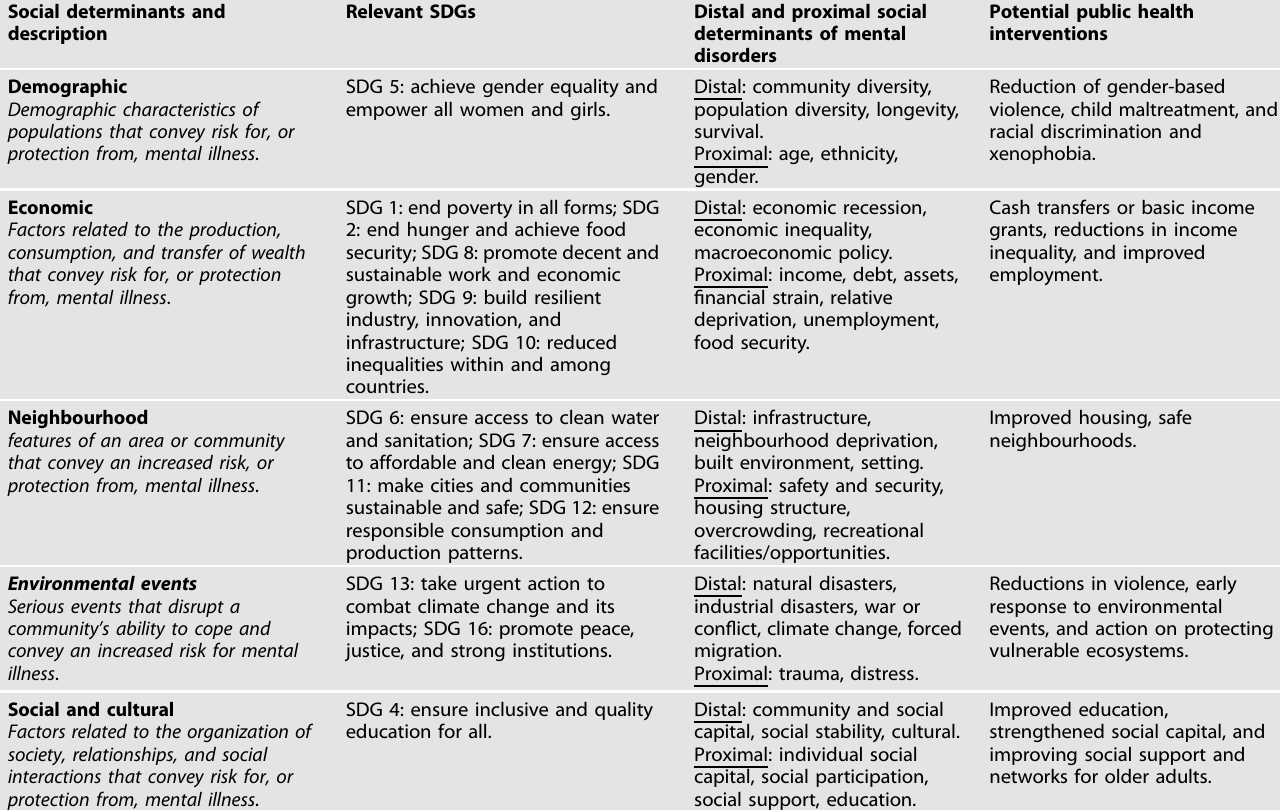
Table 1. Essential public health interventions for social determinants of mental disorders associated with the UN 2030 Sustainable Development Goals (SDG), adapted from Lund 2018